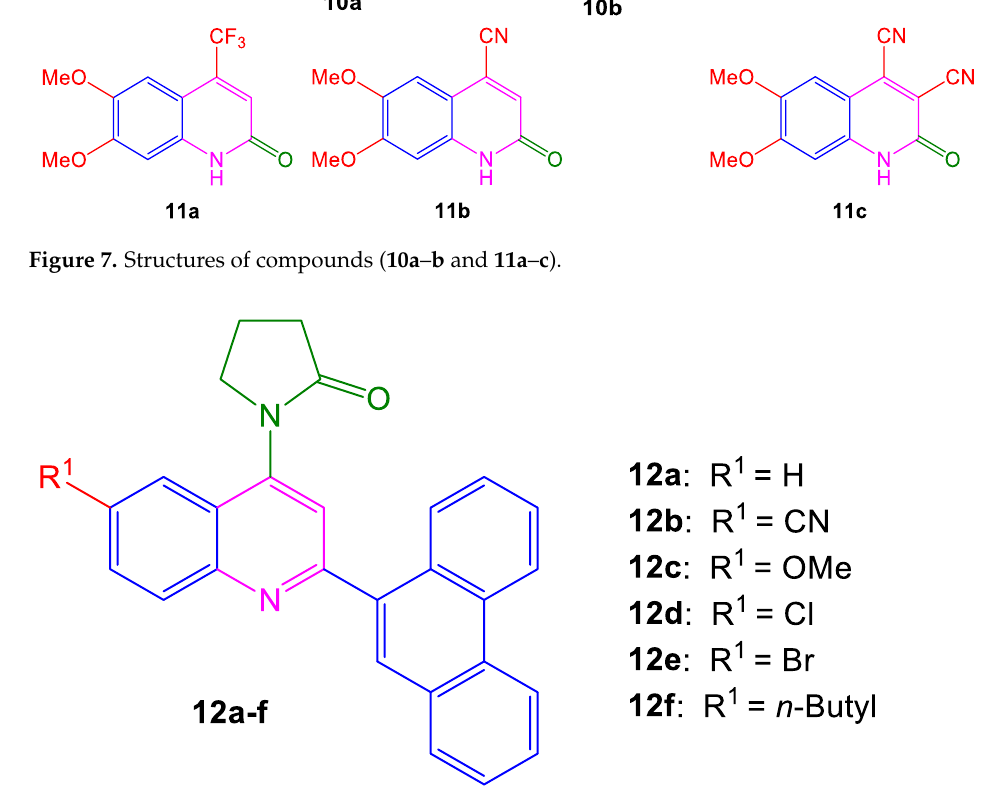
Figure 7. Structures of compounds ( 10a – b and 11a – c ).